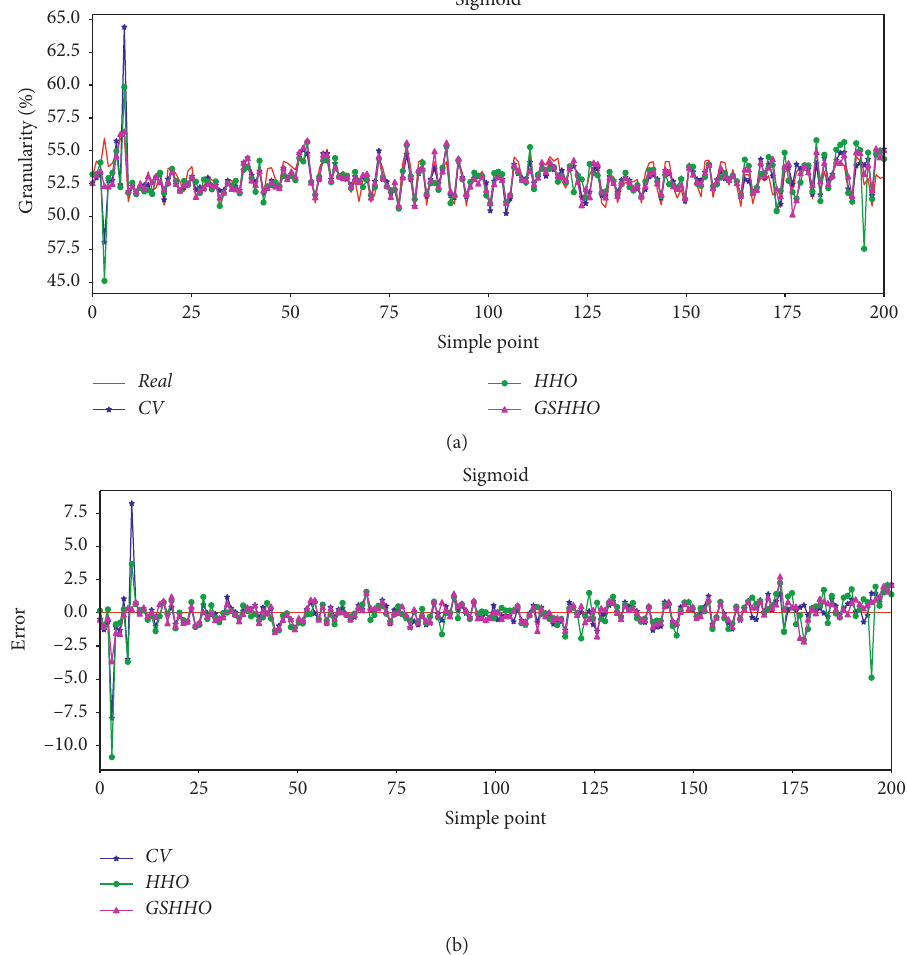
Figure 10: Prediction results under LSSVM model with sigmoi d function. (a) Prediction results under different LSSVM models. (b) Prediction errors under different LSSVM Table 8, compared with RELM and LSSVM, KNN does not show a large advantage, and its prediction accuracy is better than RELM, but still worse than LSSVM.